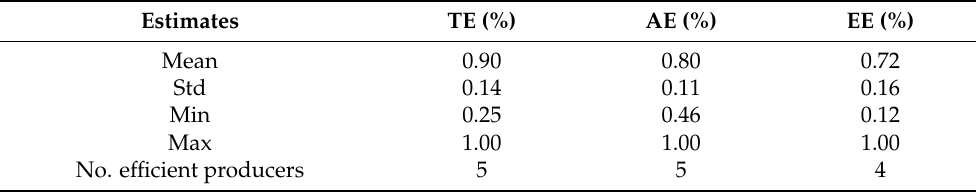
Table 2. Industry and regional productivity growth